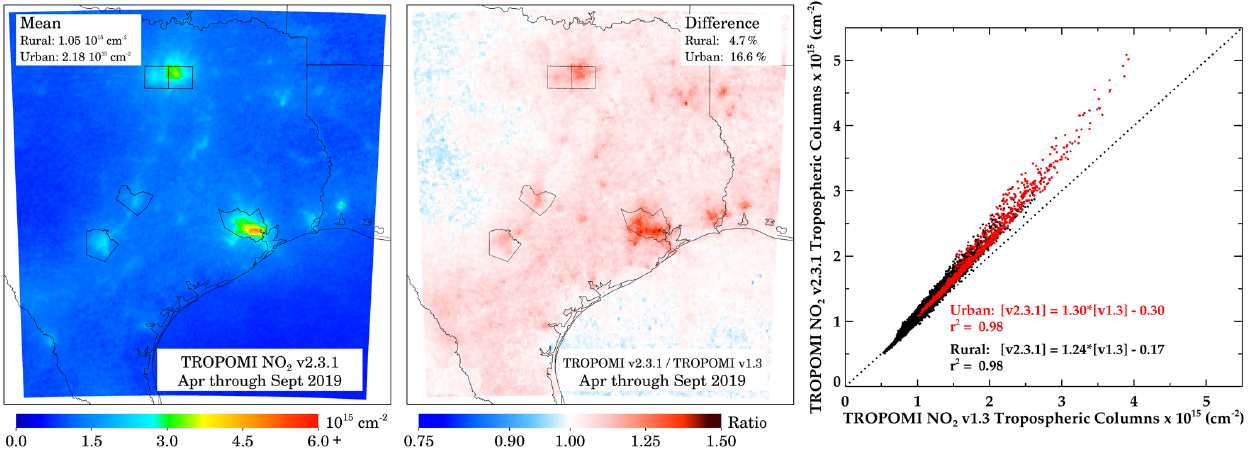
Figure 2. The left panel shows the NO 2 tropospheric vertical column amounts from the TROPOMI NO 2 v2.3.1 algorithm screened with a quality assurance flag greater than 0.75. The center panel shows the ratio between the NO 2 tropospheric vertical column amounts from the v2.3.1 algorithm compared to the v1.3 algorithm. The right panel shows a scatterplot and linear fit between the two TROPOMI NO 2 products used in the center panel. The urban area is defined as the five counties surrounding the largest five cities (Houston, Dallas, Fort Worth, San Antonio, and Austin). The rural area is everywhere outside those